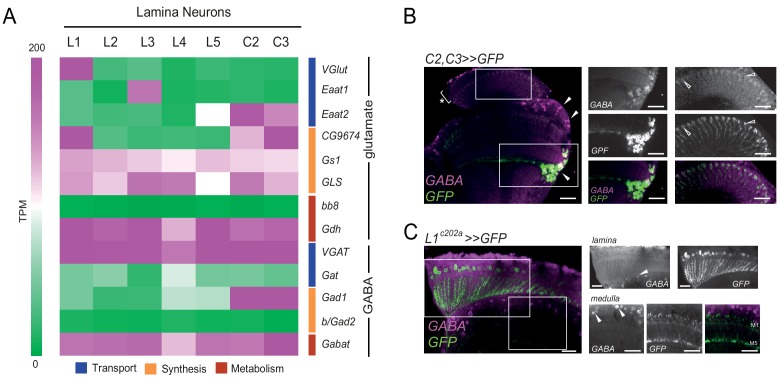
L1 neurons are not GABAergic.(A) Expression levels shown as TPM values of genes related to the synthesis, transport and release of the neurotransmitters glutamate and GABA. RNAseq data are from Davis et al. (2018) (GEO accession number: GSE 116969). Expression in the lamina neurons L1, L2, L3, L4, L5, C2 and C3. (B,C) Confocal images of the fly visual system of a fly expressing C2/C3 >> GFP (B) or L1 >>GFP (C) and marked with anti-GFP (green/gray) and anti-GABA (magenta/gray). C2/C3 are known GABAergic cell types and serve as positive controls. (B) The GABA staining shows GABA-positive signal in medulla cell bodies and C2/C3 cell bodies (filled arrowheads), as well as in C2/C3 axon terminals in the lamina (open arrowheads), but not in the lamina cortex (asterisk). (C) L1 cell bodies and medulla layers M1 and M5 housing the L1 axon terminals do not show specific anti-GABA signal whereas some medulla neuron cell bodies are GABA-positive (filled arrowheads). White boxes mark approximate location of the individual images to the left. Note that the medulla image in (C) is from a different brain. Scale bars are 20 µm.